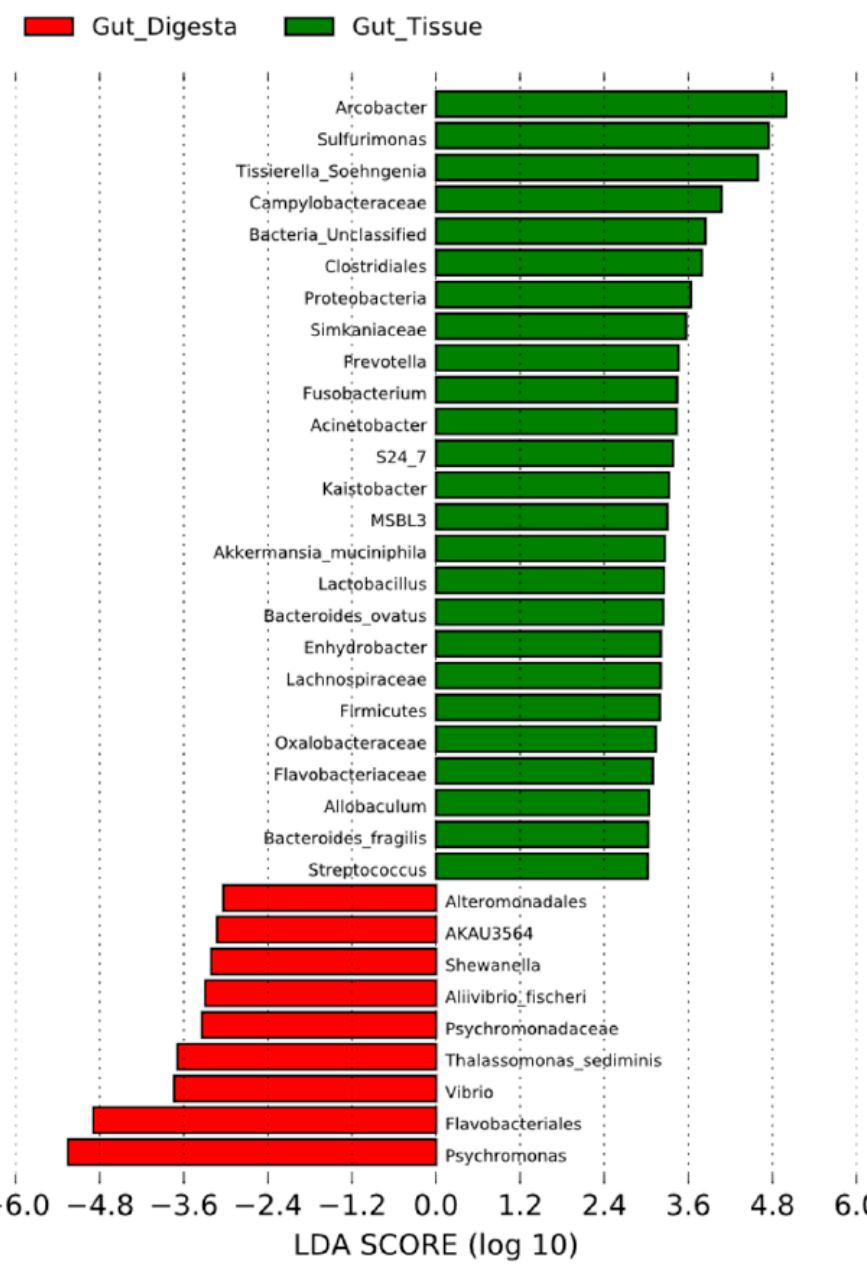
Figure 7. Linear discriminant analysis (LDA) effect size (LEfSe) performed on the microbial community relative abundance data at the of the gut tissue ( n = 3) and gut digesta ( n = 3). Grouped data were first analyzed using the Kruskal–Wallis test with a significance set to 0.05 to determine if the data was differentially distributed between groups, and those taxa that were differentially distributed were used for LDA model analysis to rank the relative abundance difference between groups. The LDA for significance was set to ± 3, and the log(10) transformed score is shown to demonstrate the effect size. Data were analyzed and prepared through Hutlab Galaxy provided through the Huttenhower lab. The gut tissue group is shown as green, and the gut digesta group as red.